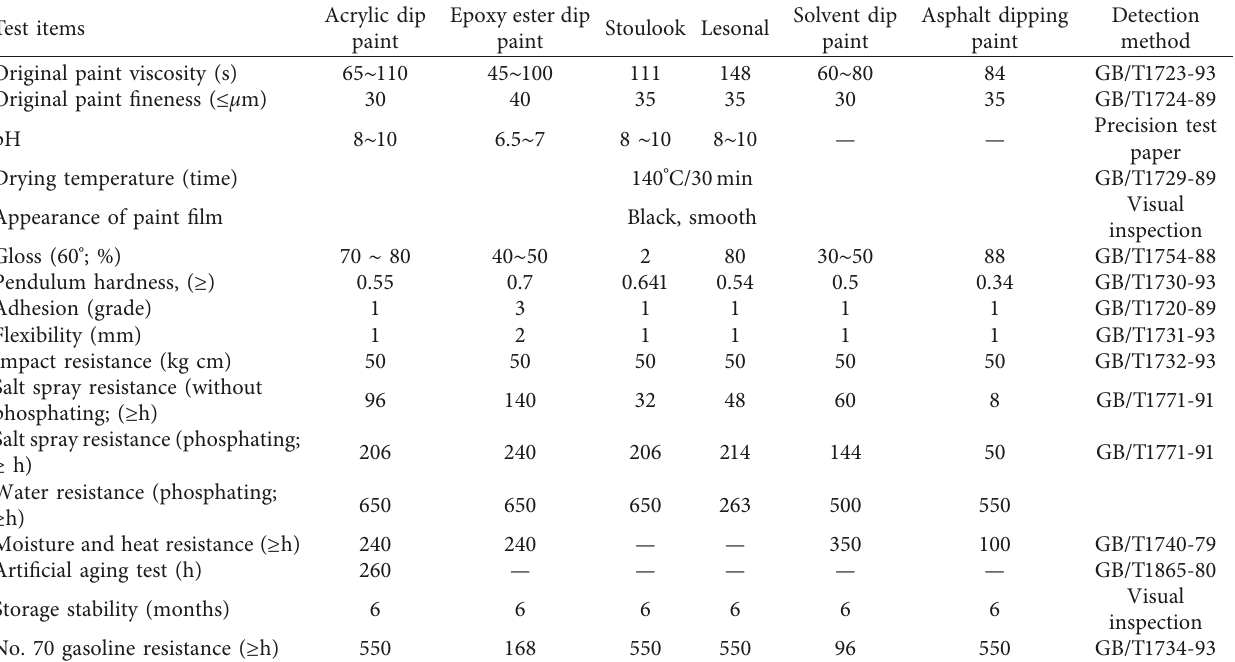
Table 3: Performance index and comparative